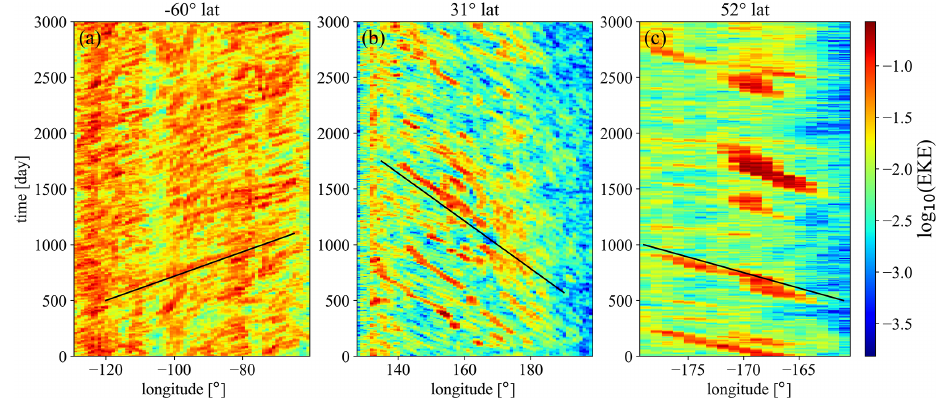
Figure 9. Hovmöller plots (time–longitude diagrams) of eddy kinetic energy propagation for three particular regions. Latitudes are indicated in the title of panels. Black lines guide the eye for characteristic slopes. Color scales are logarithmic. (a) A southern Pacific section in the region of the Antarctic Circumpolar Current at the latitude 60 ◦ S. The eastward drift speed (black line) is estimated as 5.8cms − 1 . (b) A northern Pacific section at the latitude 31 ◦ N. The westward drift speed (black line) is around − 5.2cms − 1 . (c) A northern Pacific section at the latitude of 52 ◦ N, rather close to the Fox Islands. The rare extreme energetic vortices obey a westward drift speed around − 2.9cms − 1